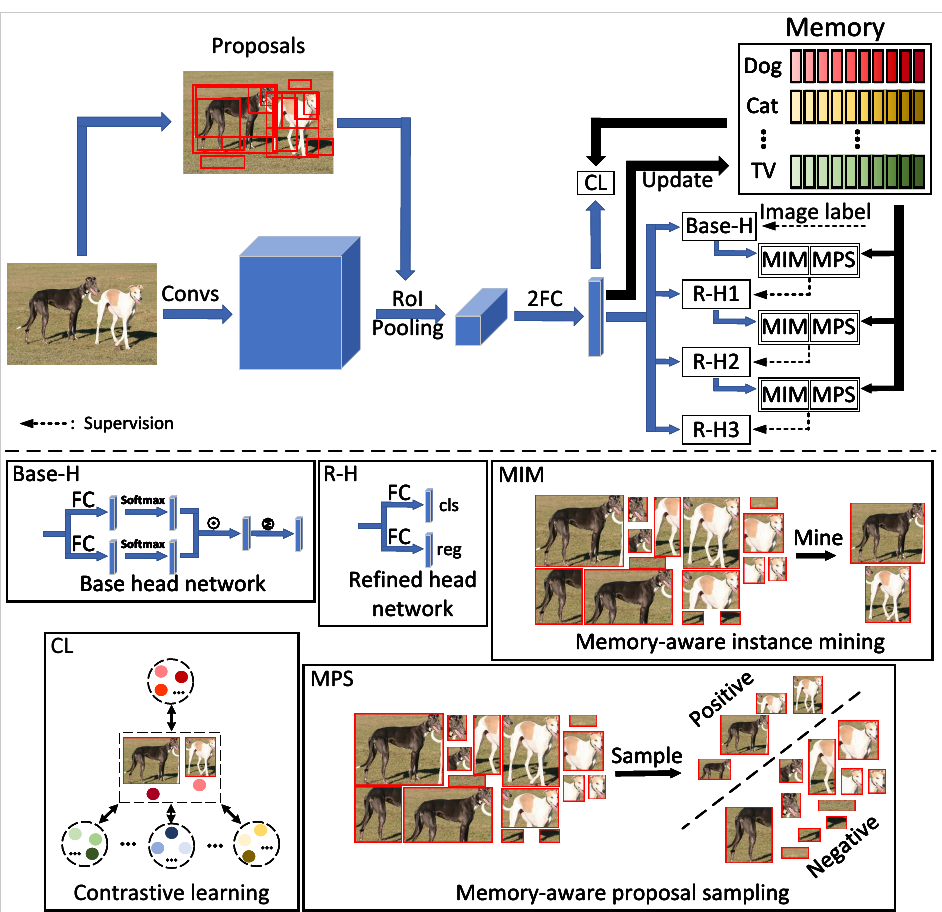
Figure 2. The pipeline of instance-level contrastive learning (ICL) framework. The upper part shows the overall network structure, where only the blue arrows backpropagate the gradients. There are one base head (Base-H) and three refined heads (R-H1, R-H2, R-H3). The base head is supervised by image labels, while each refined head is supervised by the previous parallel head. Dashed arrows indicate the supervision information. The detailed network structure of these heads can be found in the lower boxes, where each box corresponds to a submodule in the pipeline. Three refined heads have the same network structure but do not share parameters. The processes of memory-aware instance mining (MIM) algorithm, memory-aware proposal sampling (MPS) algorithm and contrastive learning (CL) are also shown in